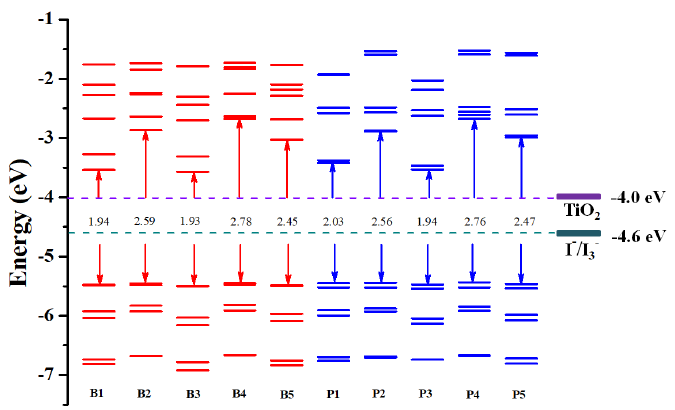
Figure 3. The molecular orbital energy levels from HOMO-5 to LUMO + 5 and HOMO-LUMO energy gaps of all the studied Cu(I)-based dyes. Molecules 2020 , 25 , x FOR PEER REVIEW